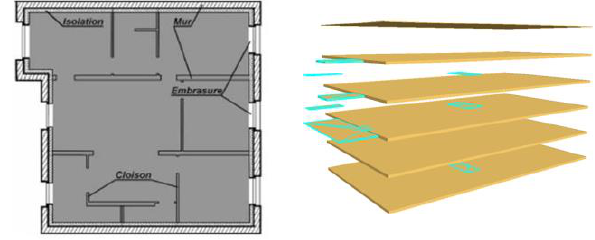
Figure 4 : using 3d GIS functionalities to delete the non-floor surface areas/ unnecessary surfaces